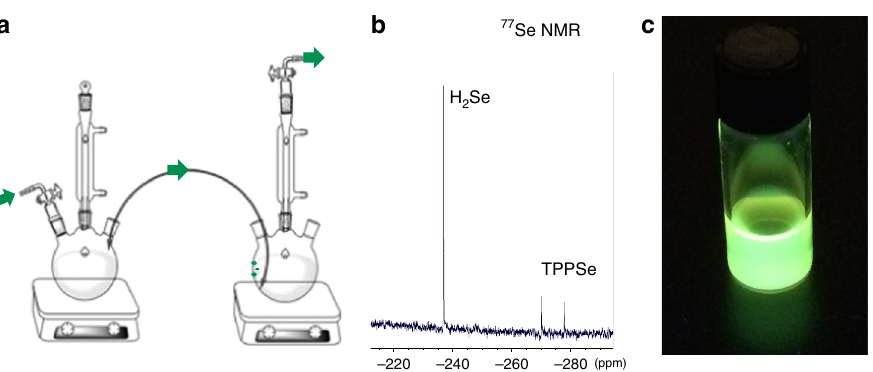
Fig. 2 Identifying the selenium decomposition product. a The experimental setup used to identify H 2 Se as the gaseous selenium source. This panel was generated using templates in ChemDraw Professional 16.0. b The 77 Se NMR spectrum of H 2 Se with TPPSe external standard. NMR characterization of TPPSe can be found in Supplementary Fig. 6. c Fluorescent CdSe nanocrystals under UV irradiation synthesized from the H 2 Se generated in situ, the absorbance spectrum is in Supplementary